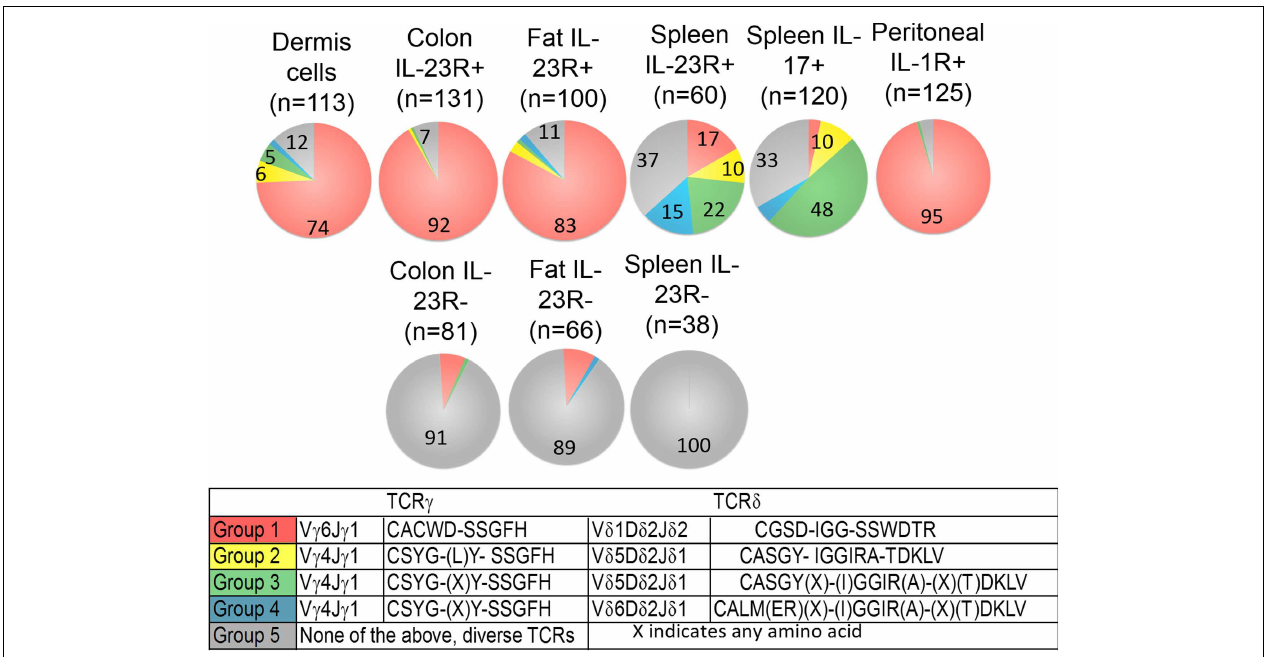
number of analyzed sequences of that cell population (Table S1 in Supplementary Material). All experiments were performed two independent times, except the analysis of spleen IL-23R + and IL-23R − γδ T cells, which were isolated and analyzed once.TCR sequences from two independent isolations and analyses are very similar and the combined results are shown. In two independent experiments, 58% and 82% of the total colon γδ T cells are IL23R + ; 74% and 86% of total fat γδ T cells are IL-23R + ; 0.1% and 0.2% of spleen cells are IL-17F + ; 2.9% of spleen γδ T cells are IL23R + . In the peritoneum 5h after infection, 12 and 30% of the γδ T cells are IL-1R +